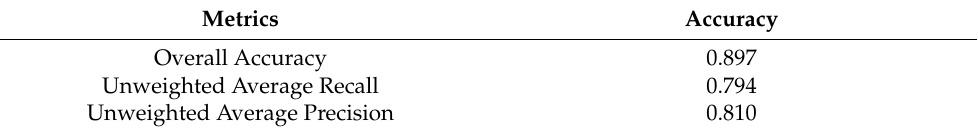
Table 6. Per-class scores in multi-class classificati on, expert’s feature set.